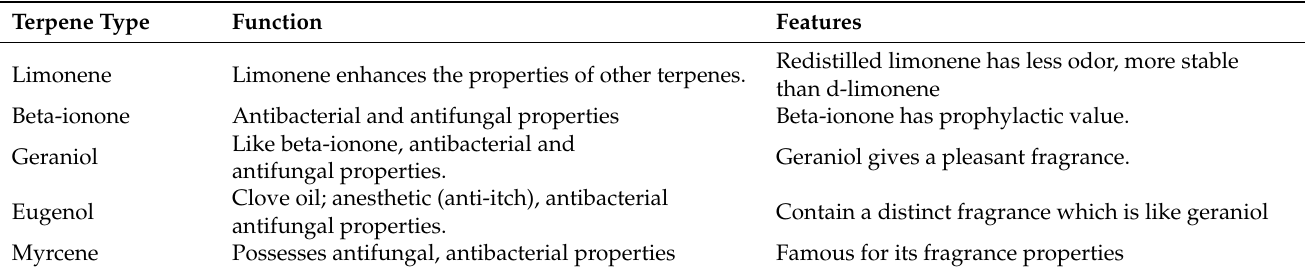
Table 8. Classifications of terpenes and their potential application as pesticides [91].